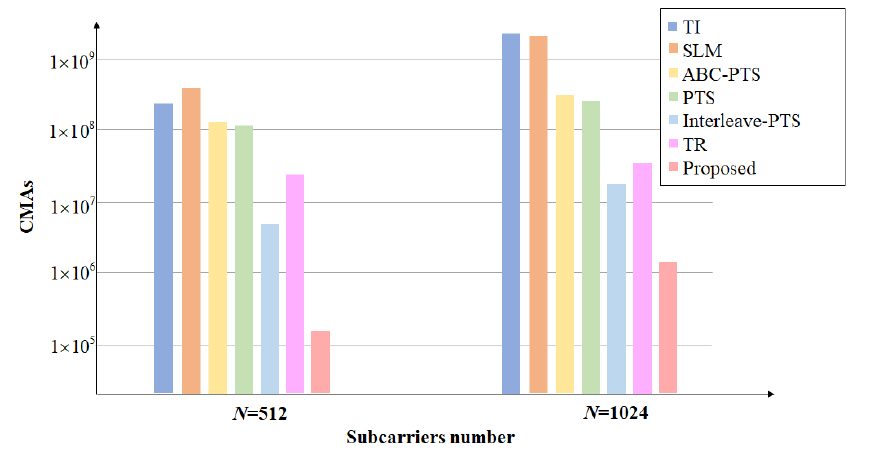
Figure 16. Computational complexity of SLM [18], PTS [21], ABC–PTS [22], interleave–PTS [23], TI [27], TR [28], and I–TR with N = 512 and N =